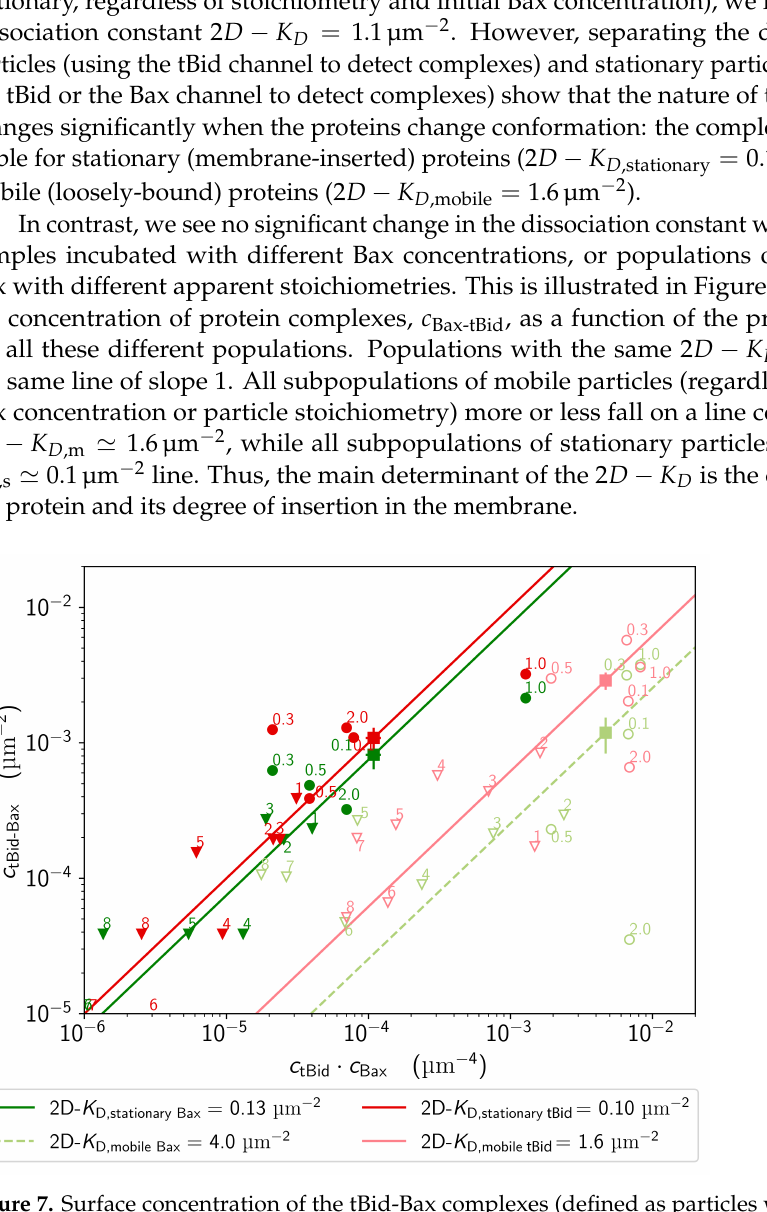
Figure 7. Surface concentration of the tBid-Bax complexes (defined as particles with χ thresh > 0.3) detected either in the Bax channel (green symbols) or the tBid channel red symbols) as a function of the product of the reactants. Data are shown both for stationary particles (dark red and dark green symbols) or mobile particles (light red and light green symbols). Each circle represents the aggregated data for a specific Bax concentration used for incubation (indicated on the figure, in nM), while each triangle represent the aggregated data for a specific oligomer size (also indicated on the figure). Squares represent the value obtained for the whole data set. The solid lines are fit of the data with Equation (7) for stationary proteins on the one hand and mobile proteins on the other hand, assuming a constant 2 D − K D (on this log-log plot the slope of these lines is 1 and their vertical offset, ] is linked to the inverse of the dissociation log [ 2 D − K − 1 D